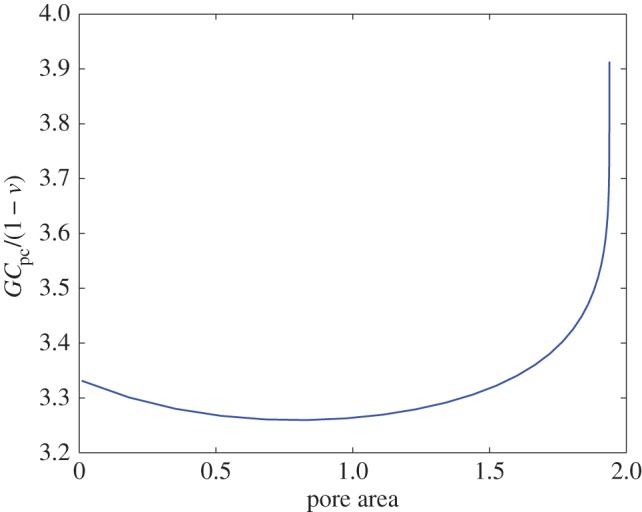
Graph of the normalized compressibility GCpc/(1−ν) against the area A of a single pore for θ=2π/3.